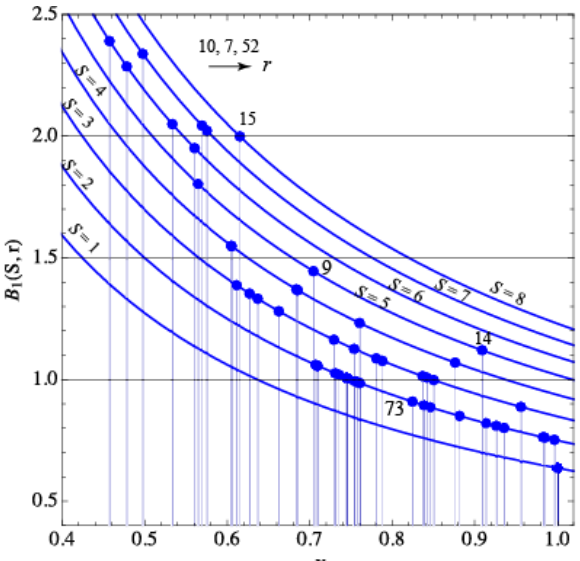
Figure 5. Comparison of natural sub-regions defined in Table 1 in terms of the biodiversity index radius = r D , where D is the Simpson index. The numbers in the vertical lines identify some sub-regions (15, 9, 14, 73); the representative points of them are located on iso-species curves ( S -curves), according to the S number of species present in the